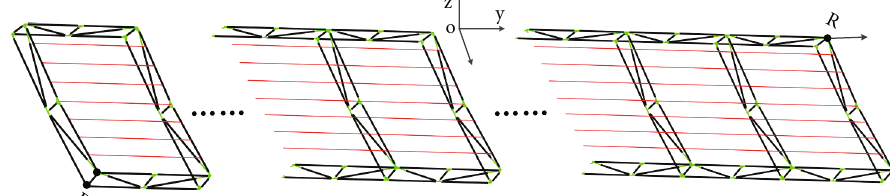
Figure 4: Modular space structure.